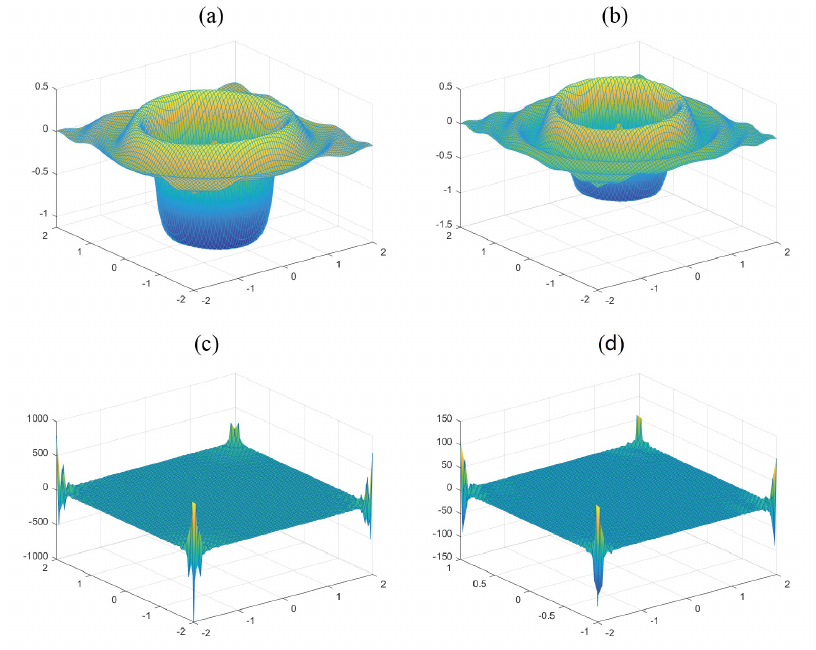
Figure 3. ( a ) Imaginary part graph of f ( x ) , ( b ) imaginary part graph of Step 1, ( c ) imaginary part graph of Step 2, ( d ) imaginary part graph of Steps 3 and 4, where Steps 1, 2, 3, 4 are the decomposition of 2D-LCT of f on Page